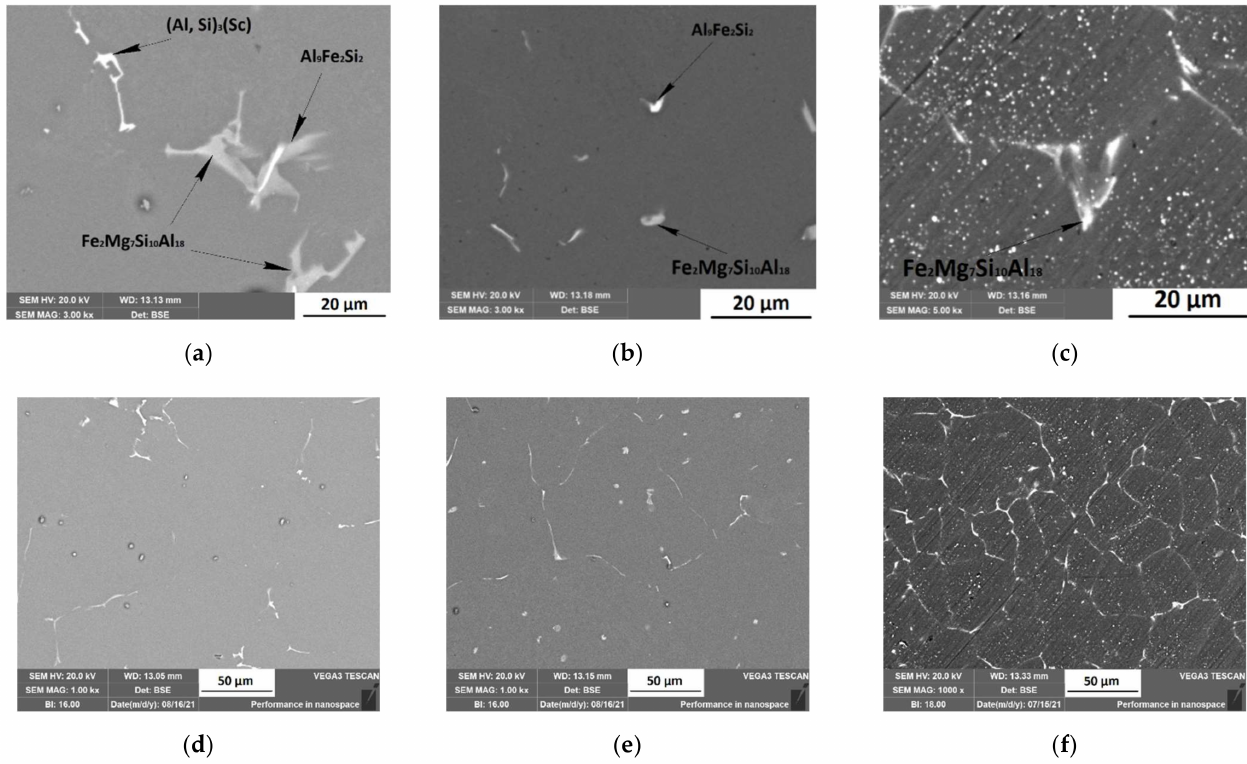
Figure 7. Micrograph of Al 0.3 Mg 1 Si 0.3 Sc 0.15 Zr alloy. Phases: ( a ) steel chill mold; ( b ) copper chill mold; ( c ) copper chill mold of round section. Intermetallic compounds: ( d ) steel chill mold; ( e ) copper chill mold; ( f ) copper chill mold of round